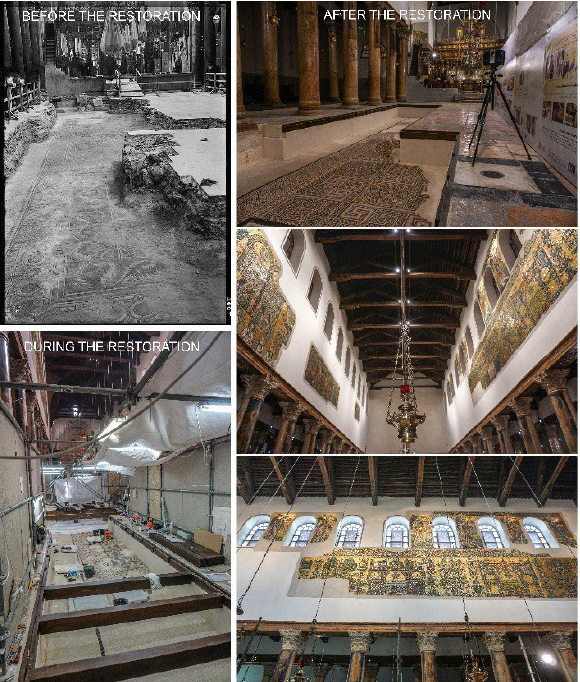
Figure 2. Pavement and walls mosaics of the Nativity Church activities and restoration of the decorative apparatus (Piacenti S.p.A. web site). Today, under the current floor, there is the possibility to admire portions of the mosaic carpet of the first